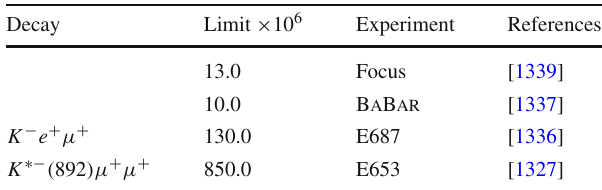
Table 301 Upper limits at 90% C.L. for D + decays